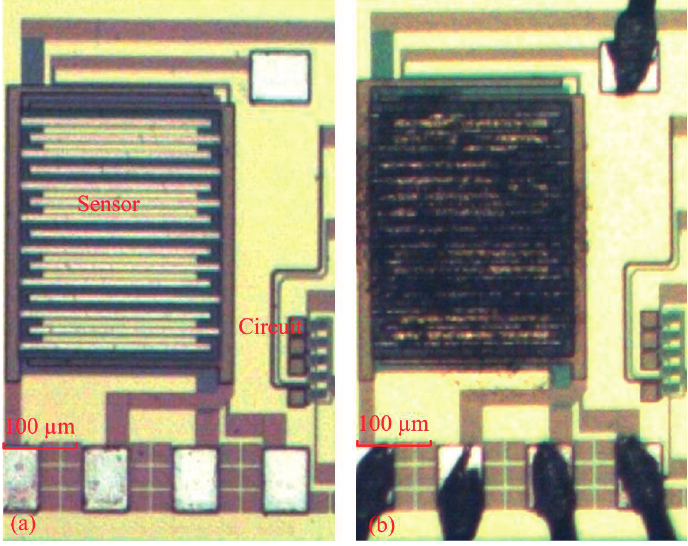
Figure 9. Optical image of the acetone microsensor, ( a ) before the post-process; ( b ) after the